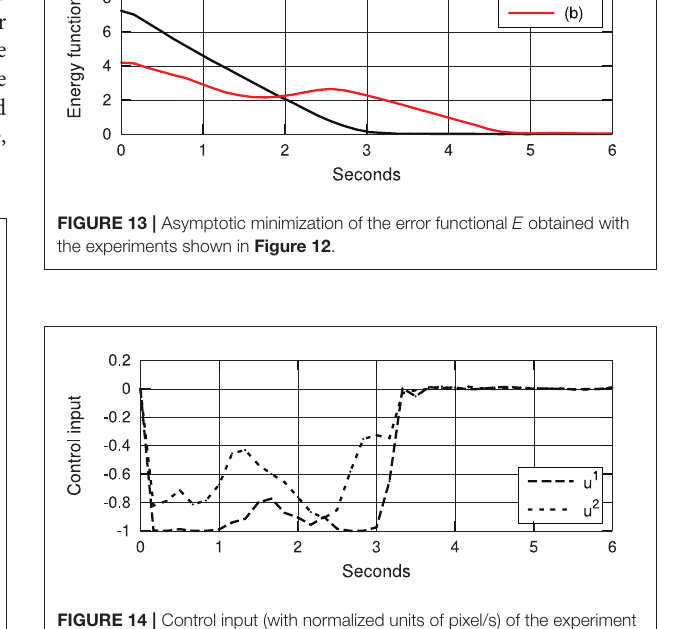
Frontiers in Neurorobotics |